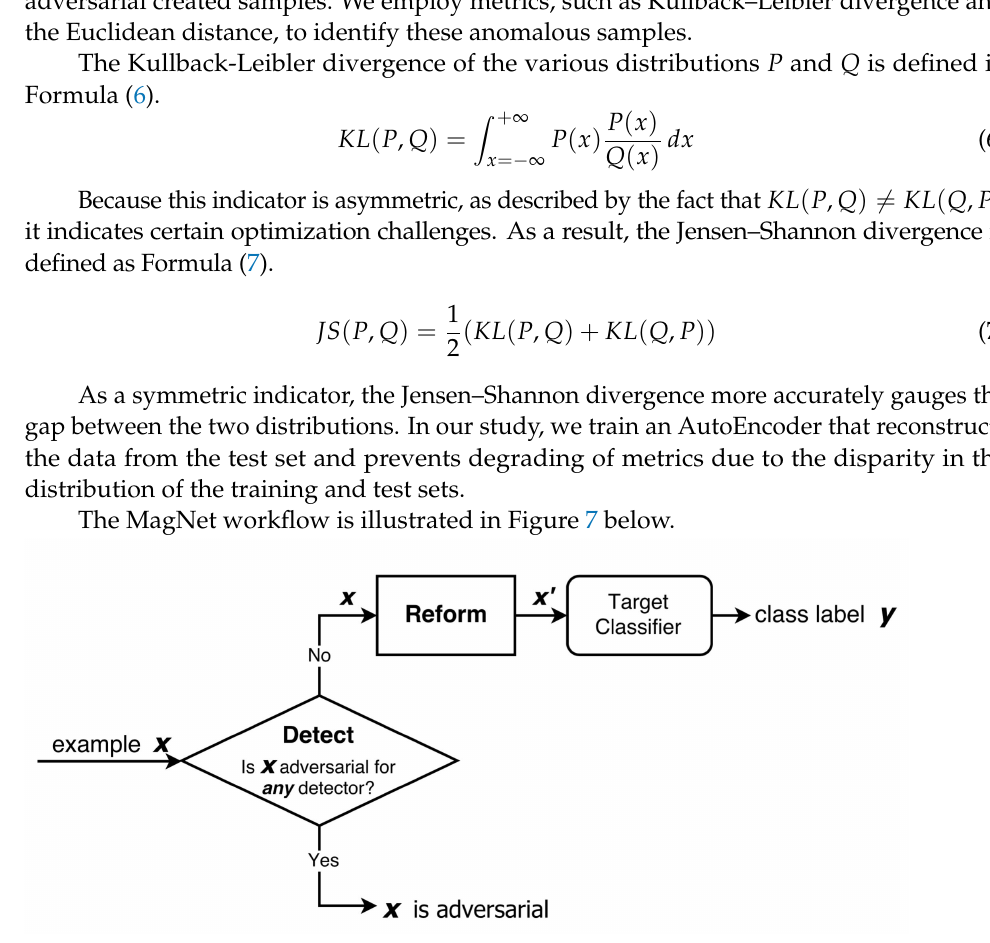
Figure 7. MagNet